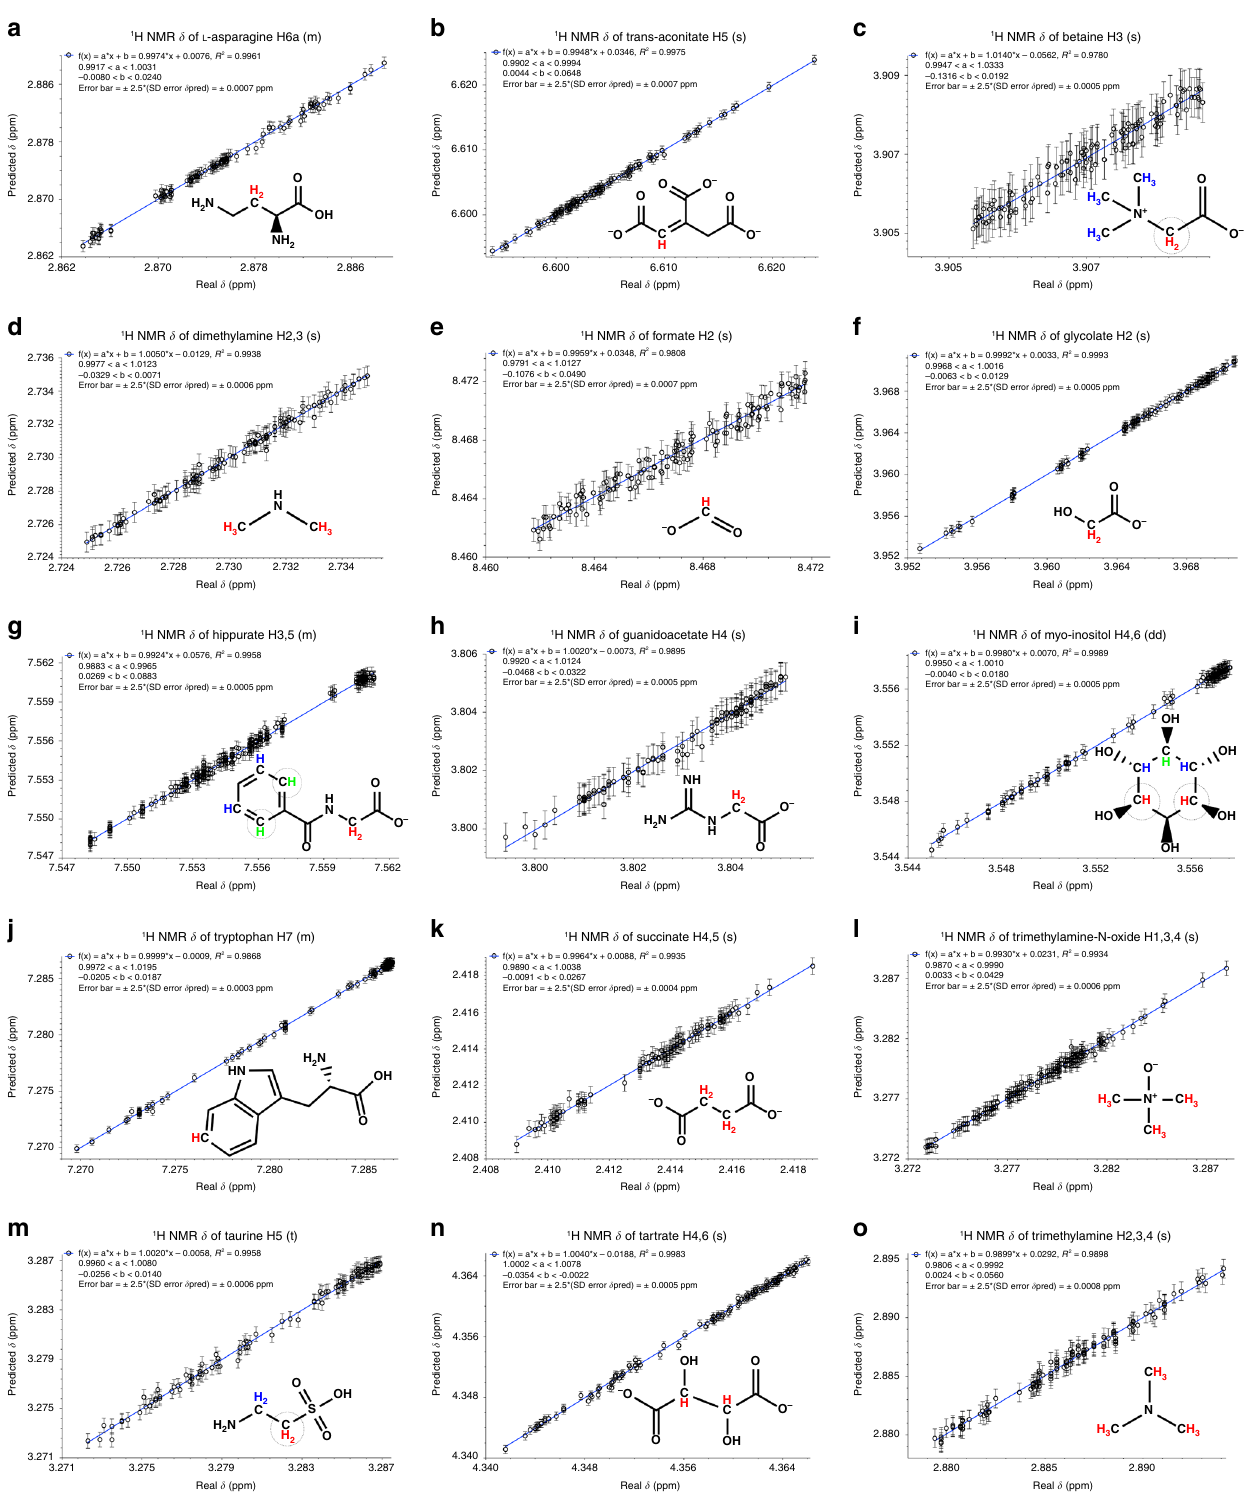
Fig. 5 Prediction of chemical shifts ( δ ) for ( a - o ) 15 spin systems of 15 selected metabolites in 120 urine NMR spectra. Colored fonts and dashed circles indicate the proton spin system for which δ is predicted. The prediction errors are within 1.5 linewidths for all spin systems, indicating the high accuracy of all predictions tested in real urine samples. The predicted chemical shifts of additional 74 spin systems of 50 metabolites are reported in Supplementary Fig.